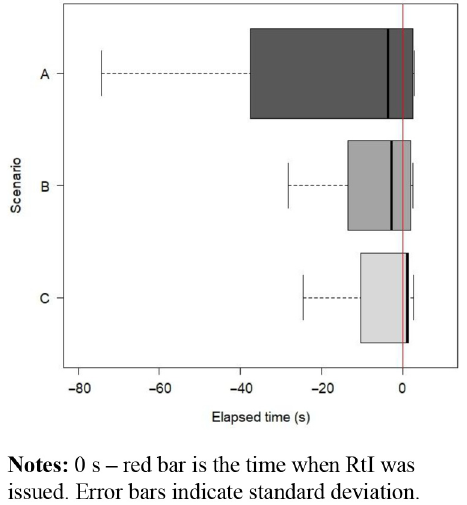
Figure 9 and Table I, half of the participants gripped the